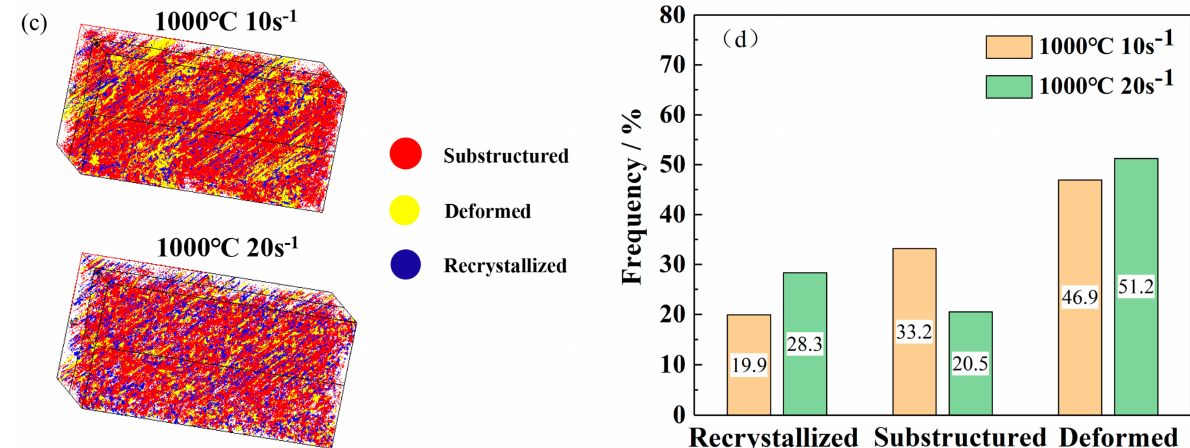
Figure 14. IPF map and misorientation distribution under conditions of ( a ) 1000 ◦ C and 10 s − 1 , ( b ) 1000 ◦ C and 20 s − 1 and their 3D DRX maps, ( c ) recrystallization ratio, and ( d ) the volume fraction of dynamic